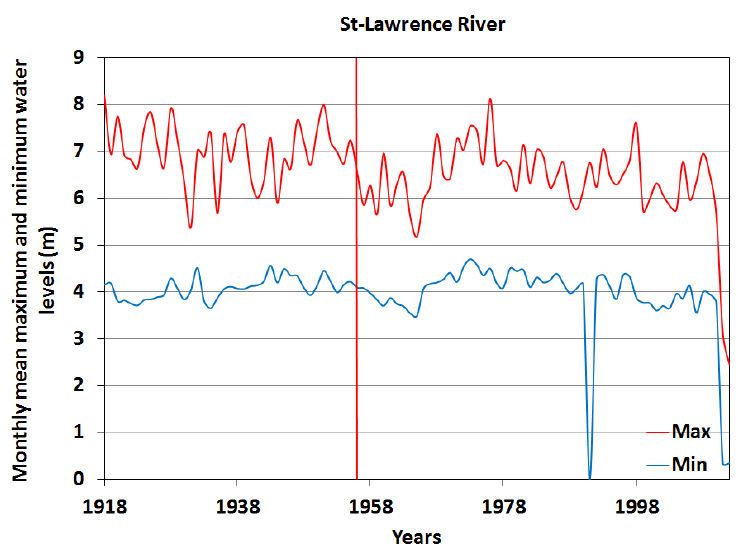
Figure 6. Temporal variability of monthly mean maximum ( red curve ) and minimum ( blue curve ) water levels in the St-Lawrence River (1918–2012). The vertical lines represent the timing of the shift in mean values of the series. Table 3. Lombard method results for monthly mean water levels in the North American Great Lakes over the period from 1918 to 2012. Analysis of variance values.